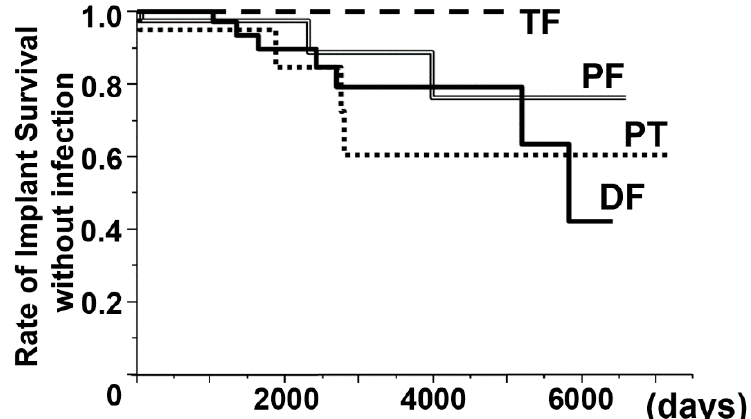
Figure 2. Rate of implant survival without infection. The rates of 5-year and 10-year implant survival without infection were 100% and 100% (Total Femur [TF], long dotted line), 98% and 89% (Proximal Femur [PF], double line), 90% and 79% (Distal Femur [DF], solid line), and 95% and 60% (Proximal Tibia [PT], short dotted line).